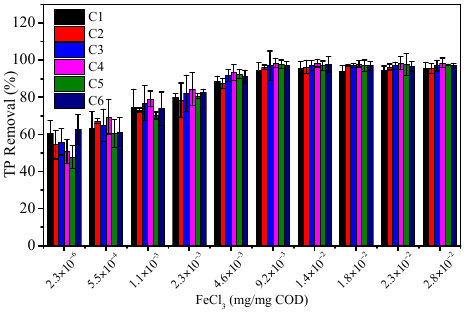
Figure 2. Effect of coagulation on TP removal efficiencies.